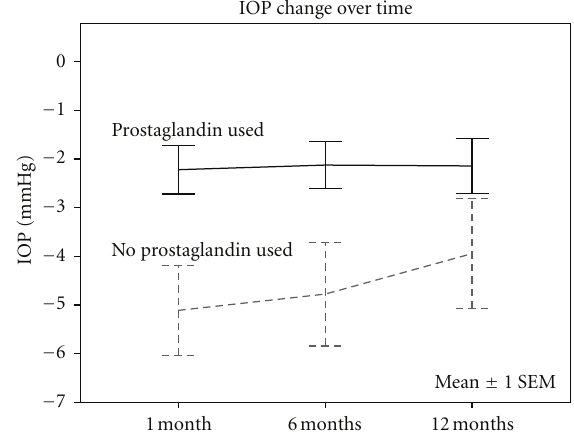
Figure 1: Graph comparing IOP change over time of patients treated with prostaglandin analogues to those treated with other medical treatments prior to SLT. The IOP change shown in the graph is the mean of the di ff erences between the IOP of the treated and fellow eyes in both groups at each time point, and the IOP change has been controlled for baseline